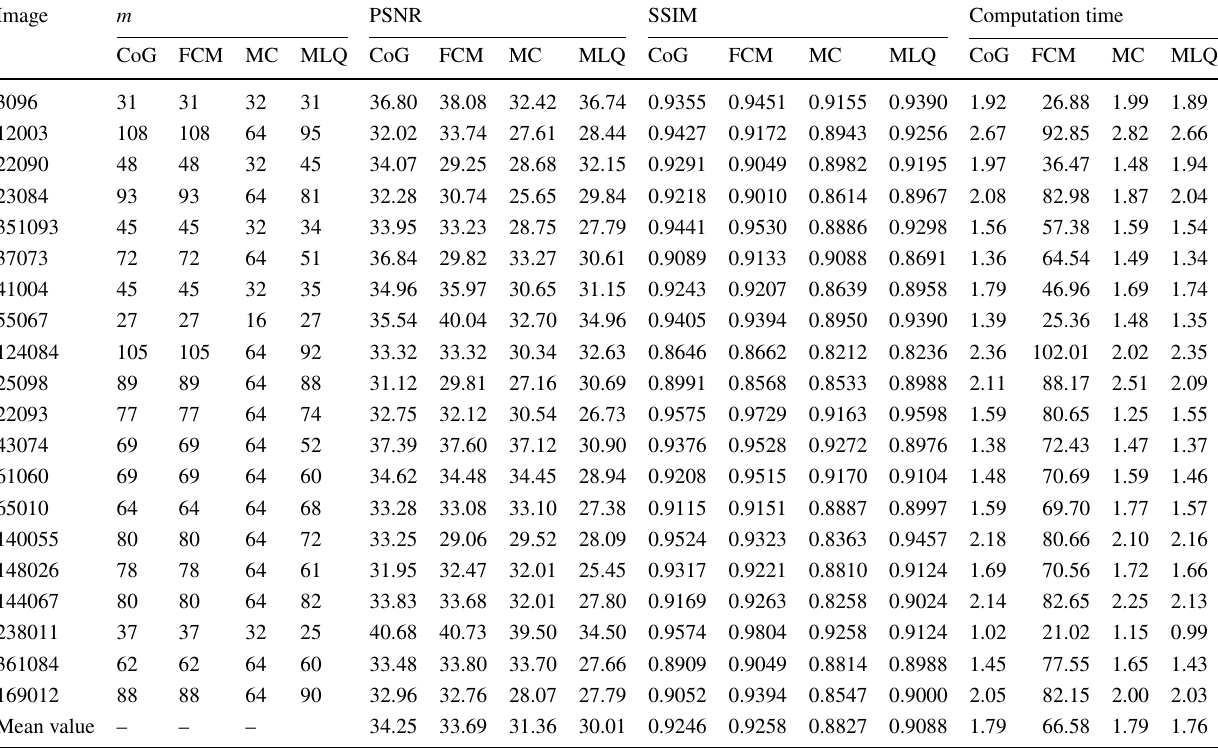
Table 6 Overall performance of algorithms with various metrics for t = 5